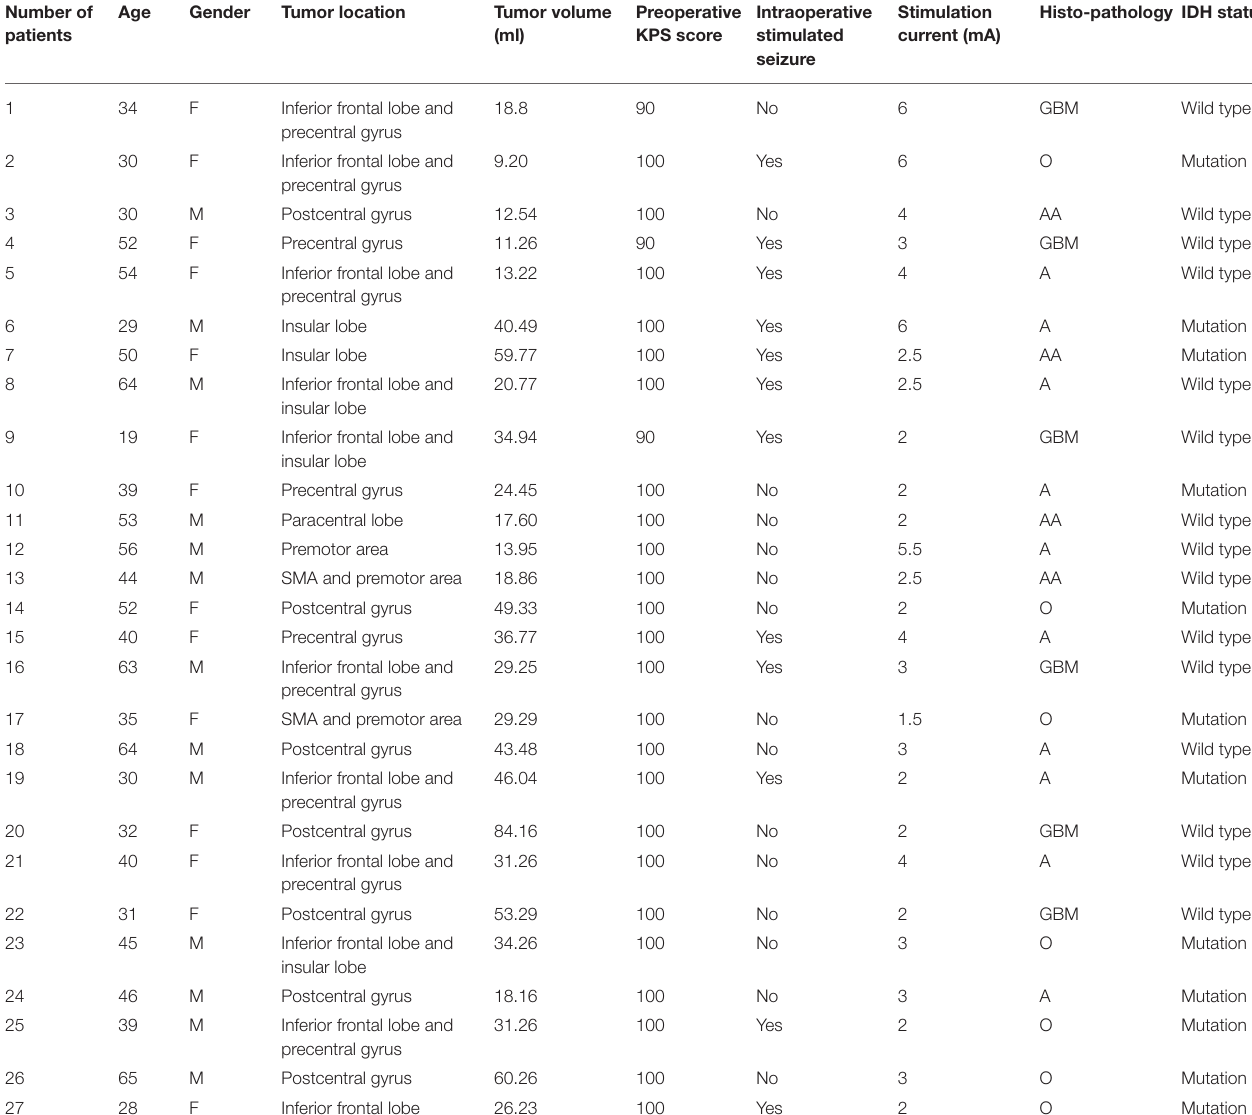
TABLE 2 | Clinical information of enrolled patients. Number of